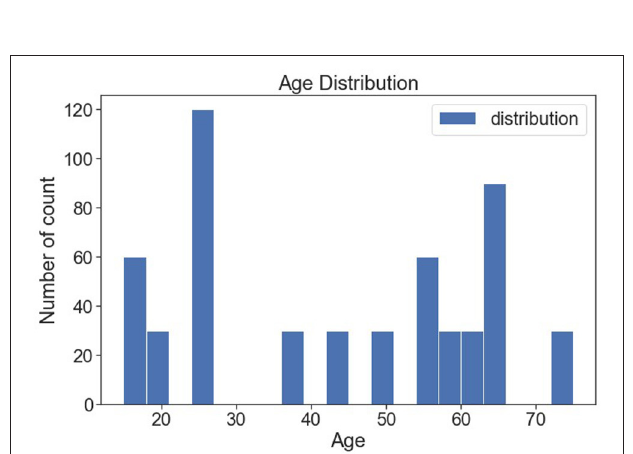
FIGURE 11 | Age distribution